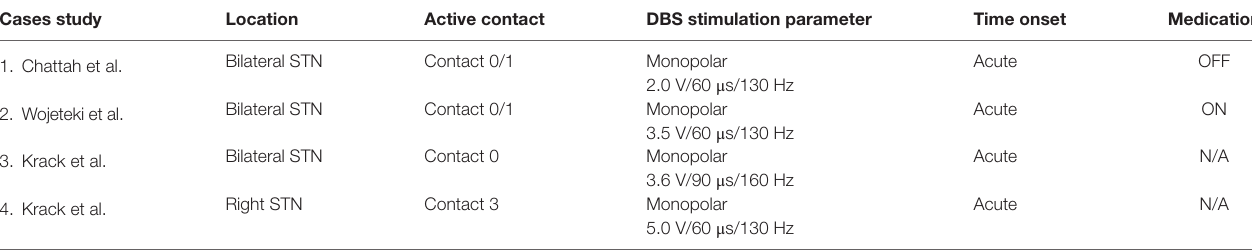
taBLe 2 | Clinical characteristics and DBS settings in previous case studies. Cases